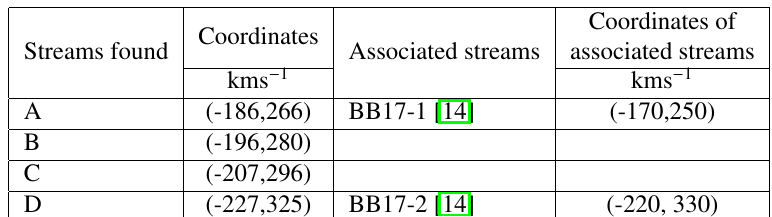
Table 2: Streams found and associated